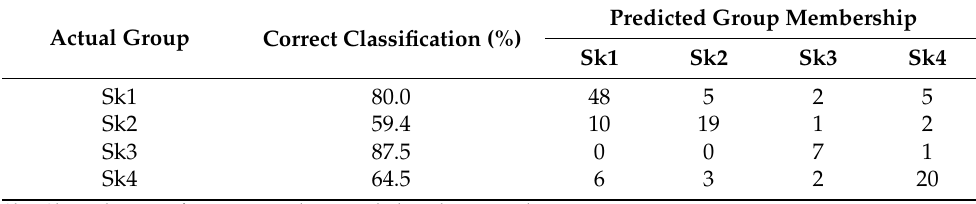
Table 3. Classification results of LDA presenting percentage predicted group membership for actual